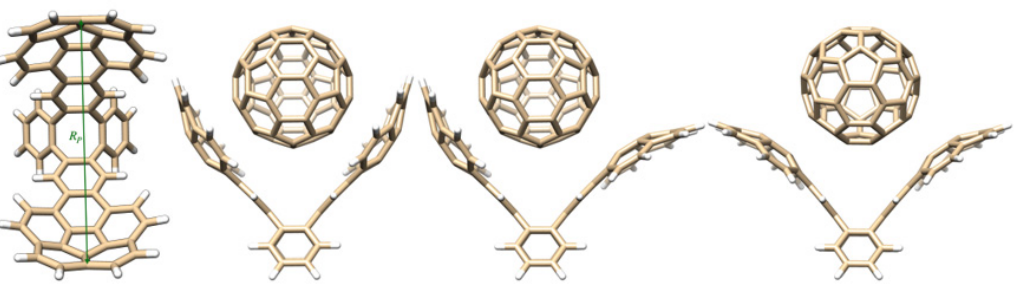
Figure 1. From left to right: definition of the R P parameter used to evaluate the width of opening for the buckycatcher and the structure of the buckycatcher complexes with C 60 ; complex formed with ii ; adduct with ie ; complex with ee . Table 1. 𝑅 (cid:3017) distances (in Å) or the several conformers of the corannulene pincer according to the four methods used in this study.